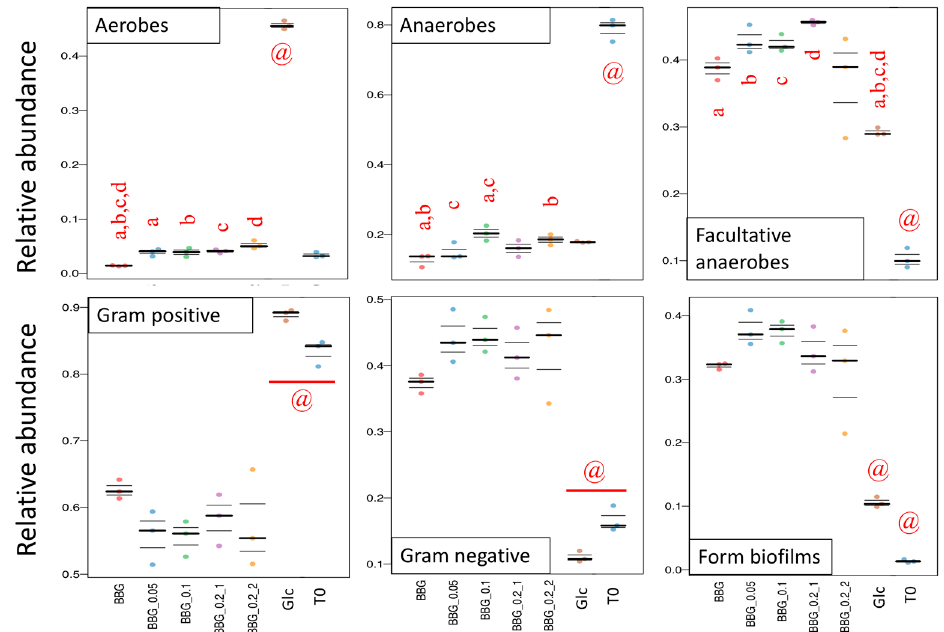
Figure 4. Predicted output of selected phenotype by BugBase. Relative abundance of aerobes, anaerobes and facultative anaerobes are in the upper panel. Gram-positive bacteria, Gram-negative bacteria and taxa that are predicted to form biofilm are given in the lower panel. Significant difference analyzed by one-way ANOVA (Tukey HSD post-hoc test), p < 0.05. @: denotes statistically significant different from all other groups.